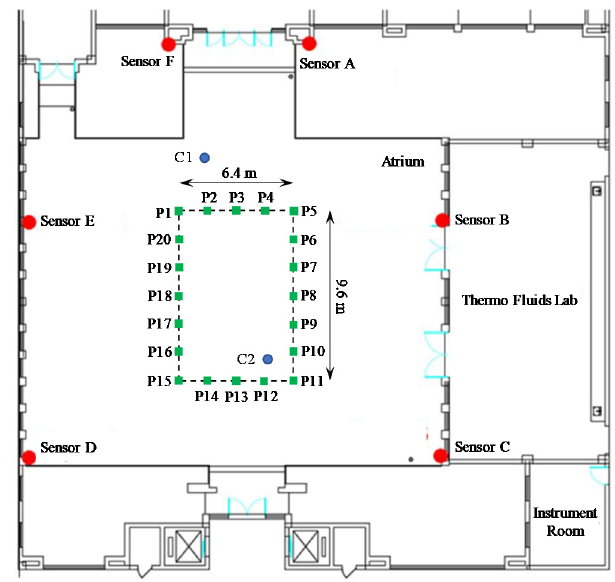
Figure 2. Locations of the known UWB sensors and test points at the test site. The red dots are the UWB sensors, and the green dots are the test points. The black dashed line is the rectangular track which the trolley travels on.